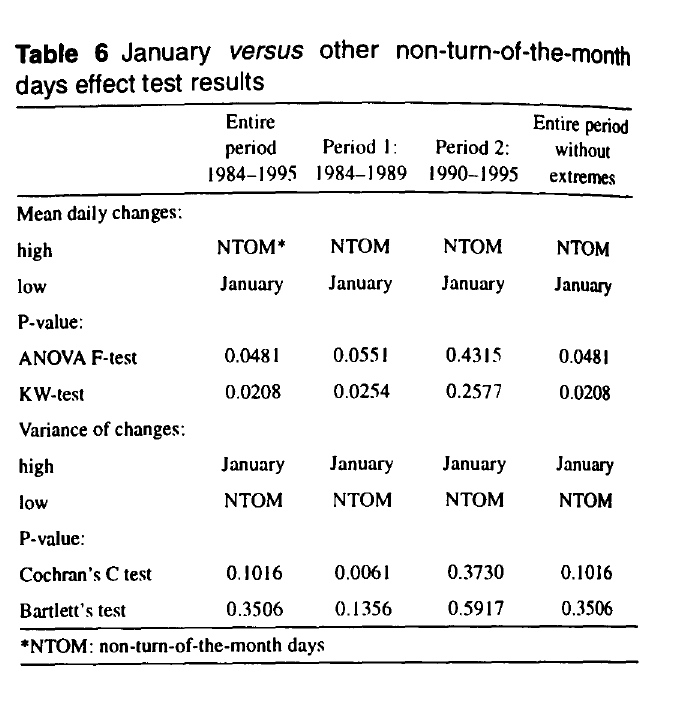
Table 6 January versus other non-turn-of-the-month days effect test